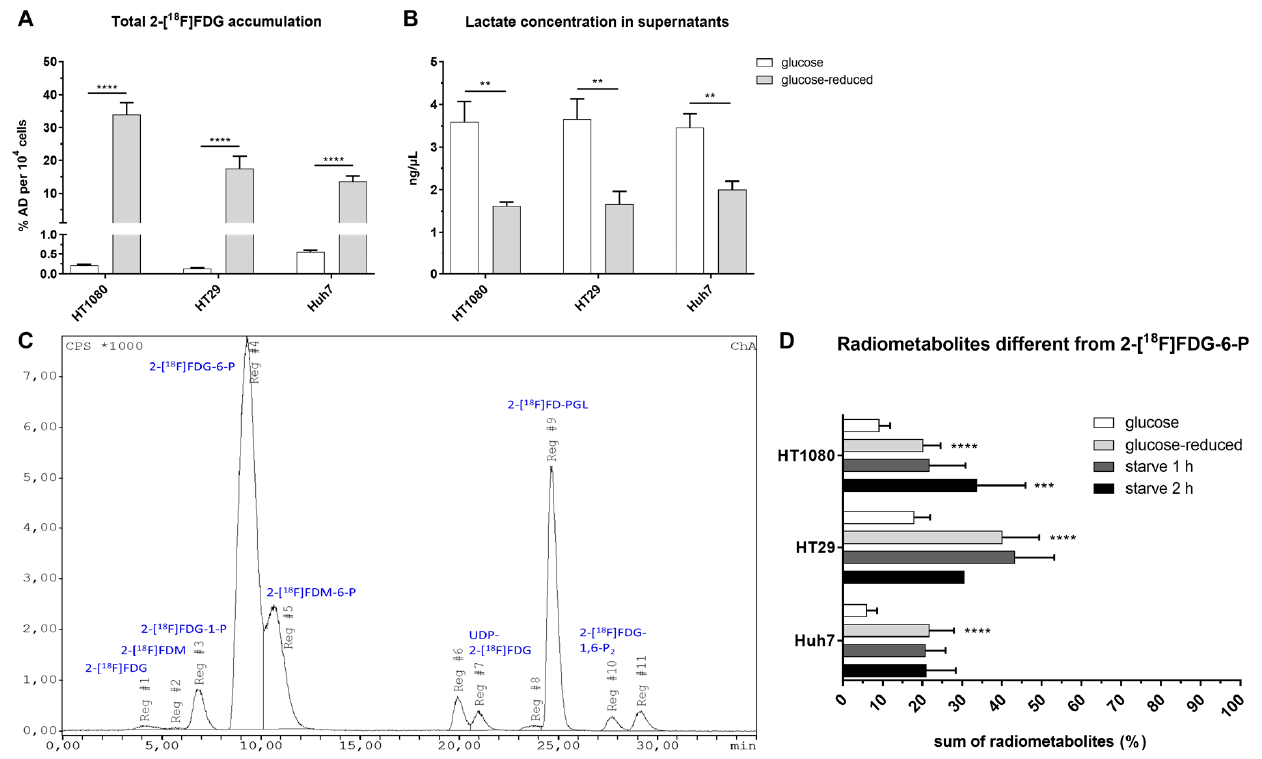
Figure 3. Total intracellular 2-[ 18 F]FDG accumulation after 1 h ( A ) and lactate concentration in the supernatants at the end of the experiment (** p ≤ 0.01) ( B ). ( C ) shows a representative image of the radiometabolite pattern under glucose-reduced conditions in HT29 after 1 h and ( D ) the sum of radiometabolites other than 2-[ 18 F]FDG-6-P after 1 h in % (**** p ≤ 0.0001, *** p ≤ 0.001 compared to glucose conditions). Conditions: glucose = 1.13 g/L, glucose-reduced = 0.13 g/L, starve = glucose-reduced medium 1 or 2 h prior to 2-[ 18 F]FDG addition. If not visible, the error bars are within the margin of the symbols.